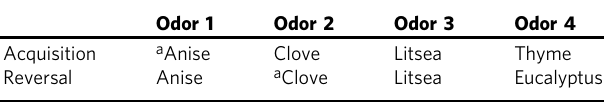
in the four-choice